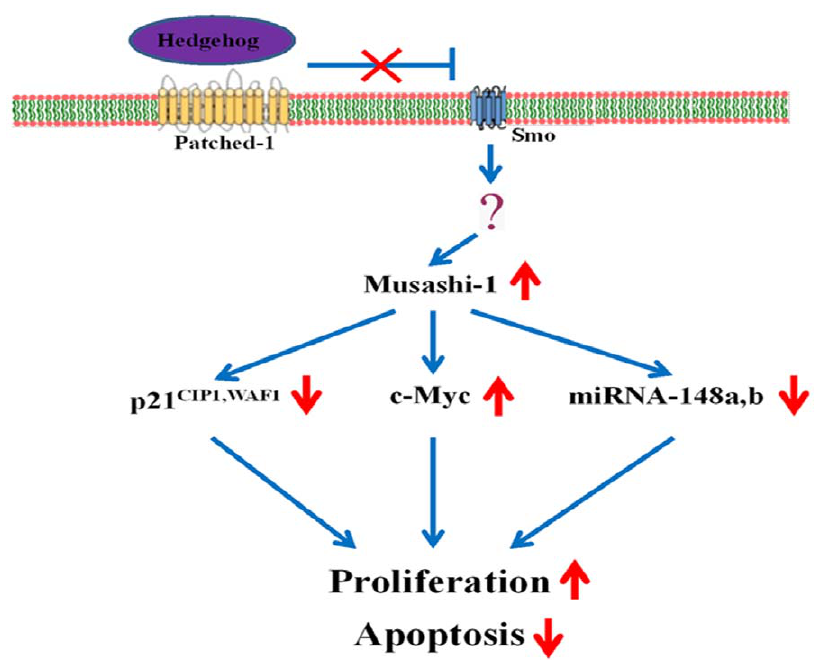
Figure 9. A schematic diagram showing the proposed Hedgehog signaling cascade that regulates the apoptosis and proliferation of MSCs. The Hedgehog agonist purmorphamine enhanced cell proliferation and suppressed apoptosis through the RNA-binding protein Msi1 by regulating the expression of an oncoprotein (i.e., c-Myc), a cell cycle regulatory molecule (i.e., p21 CIP1,WAF1 ) and two miRNAs (i.e., miRNA-148a and